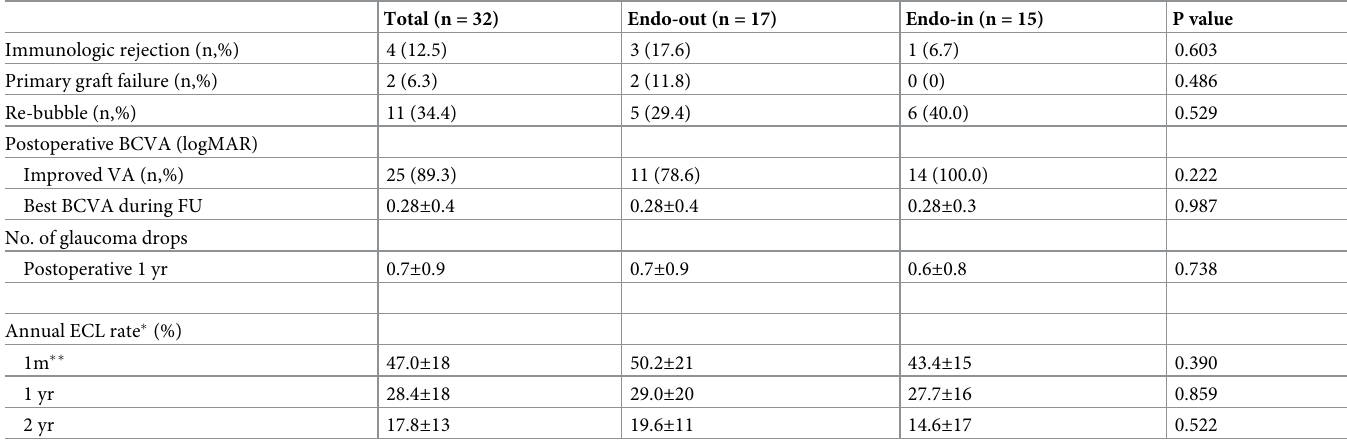
Table 2. Postoperative clinical outcomes.